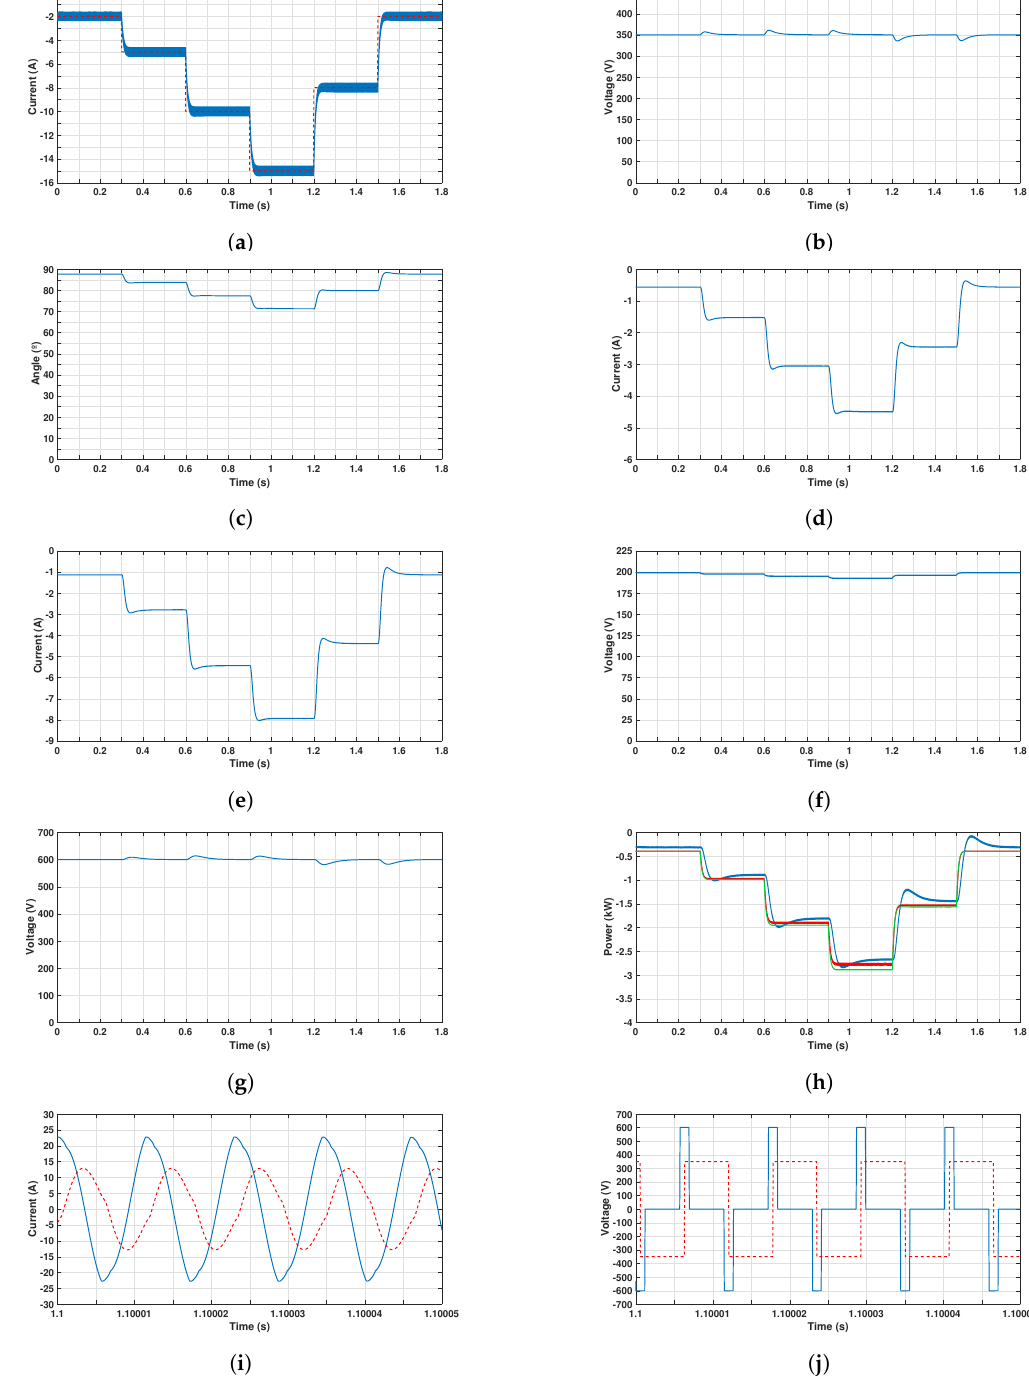
Figure 13. Results obtained for the V2G mode. Time responses of ( a ) the battery current i b (blue) and the reference i ∗ (red); ( b ) the DC voltage v DC 2 ; ( c ) the phase-shift angle α ; ( d ) the current i in ; ( e ) the current i 0 ; b ( f ) the voltage of the battery v b ; ( g ) the DC voltage v DC 1 ; ( h ) the grid power P g (blue), the power at the input of the DC–DC converter P dc (red) and the battery power P b (green); ( i ) currents of the compensated magnetic coupler i 1 (blue), and i 2 (red); ( j ) voltages across the compensated magnetic coupler v 1 (blue), and v 2